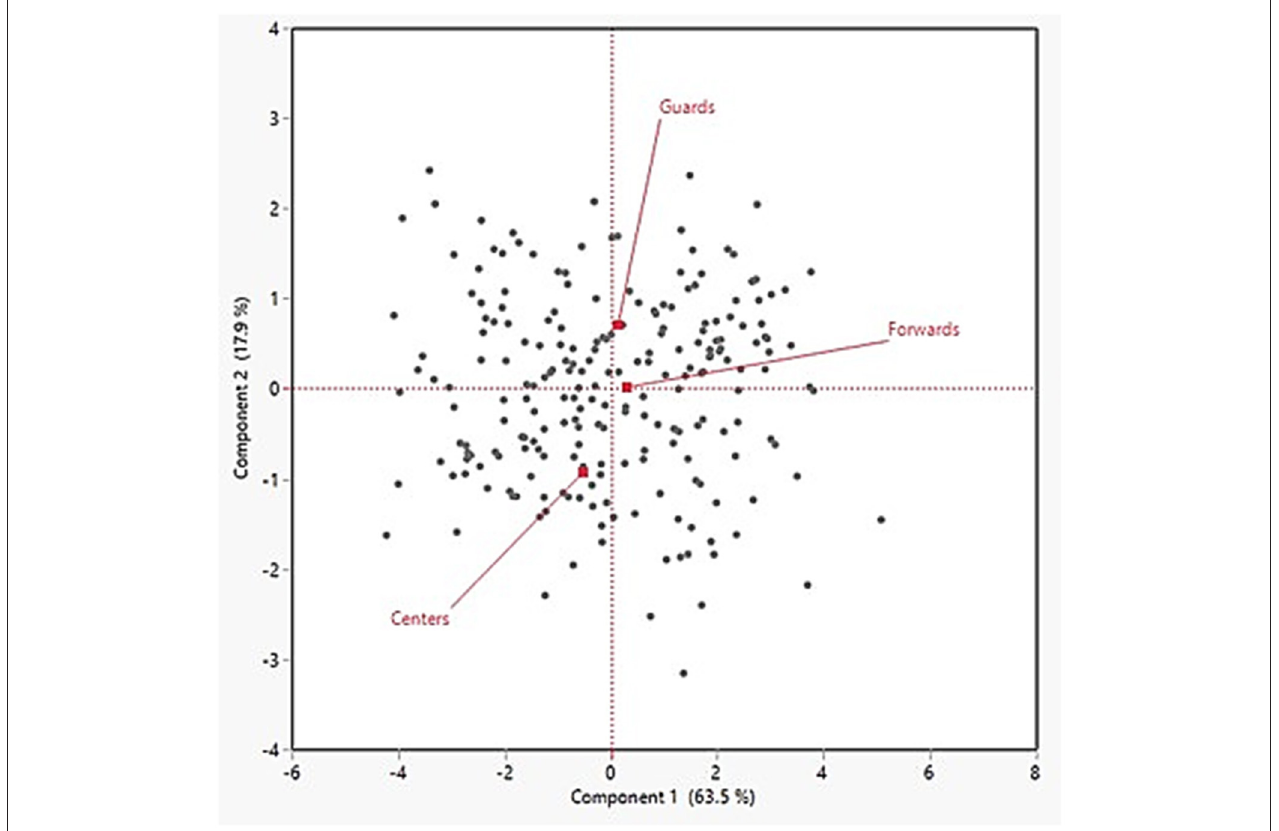
FIGURE 1 | Individual observations derived from the principal component analysis and supplemented with the player position variable.